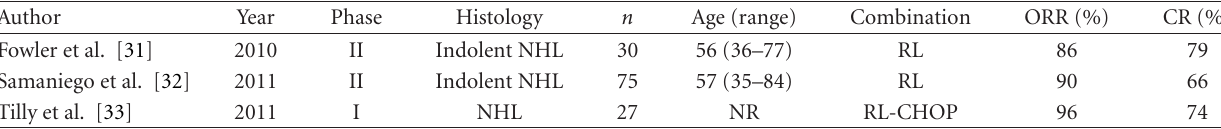
Table 5: Lenalidomide containing regimens in untreated indolent and mantle cell lymphoma.